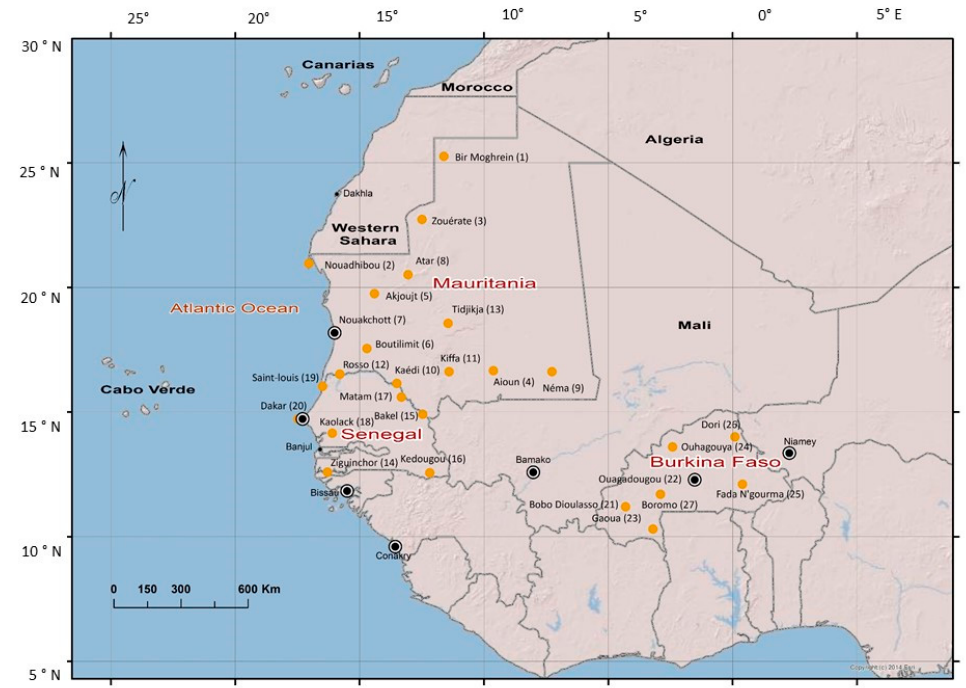
Figure 1. Geographical position of the 27 weather stations cited. The number between the brackets indicates the position of stations in the chronological graphic method of information processing (MGCTI) of “Bertin matrix” type (Figure 2) The data were collected from the weather services in Senegal (ANACIM)